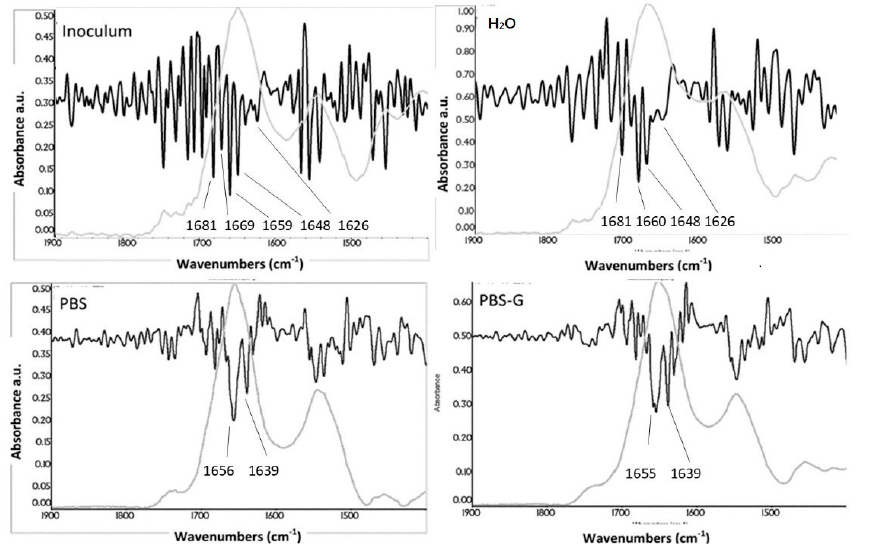
Figure 7. Second derivatives of the FTIR spectra of S. epidermidis (SE) biofilms at Inoculum (upper left), in H 2 O (upper right), PBS (lower left) and PBS-G (lower right) (for related spectra see Figures 5).